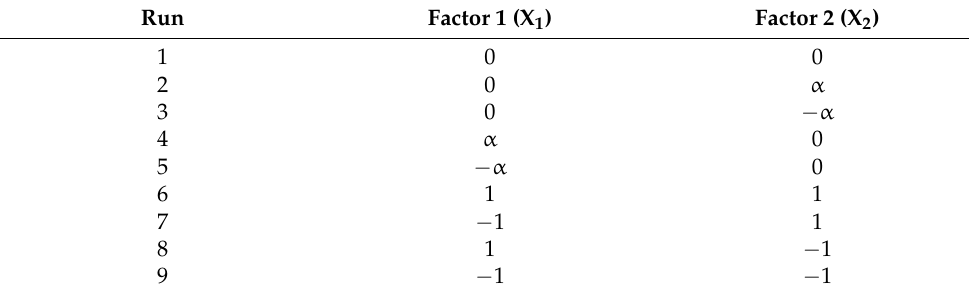
Table 2. Two factor CCD matrix, with one central point.